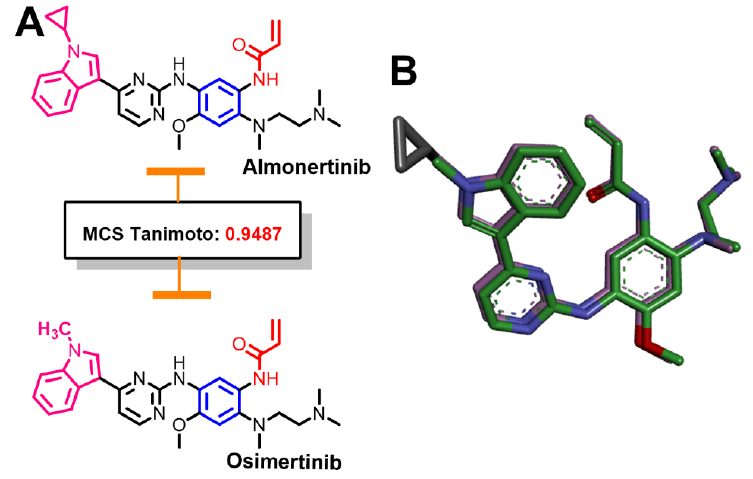
Figure 3. Structural similarity of almonertinib and osimertinib: ( A ) 2D representations showing the equivalent fragments indicated by the same color; ( B ) overlay view of the two molecules (3D representations).